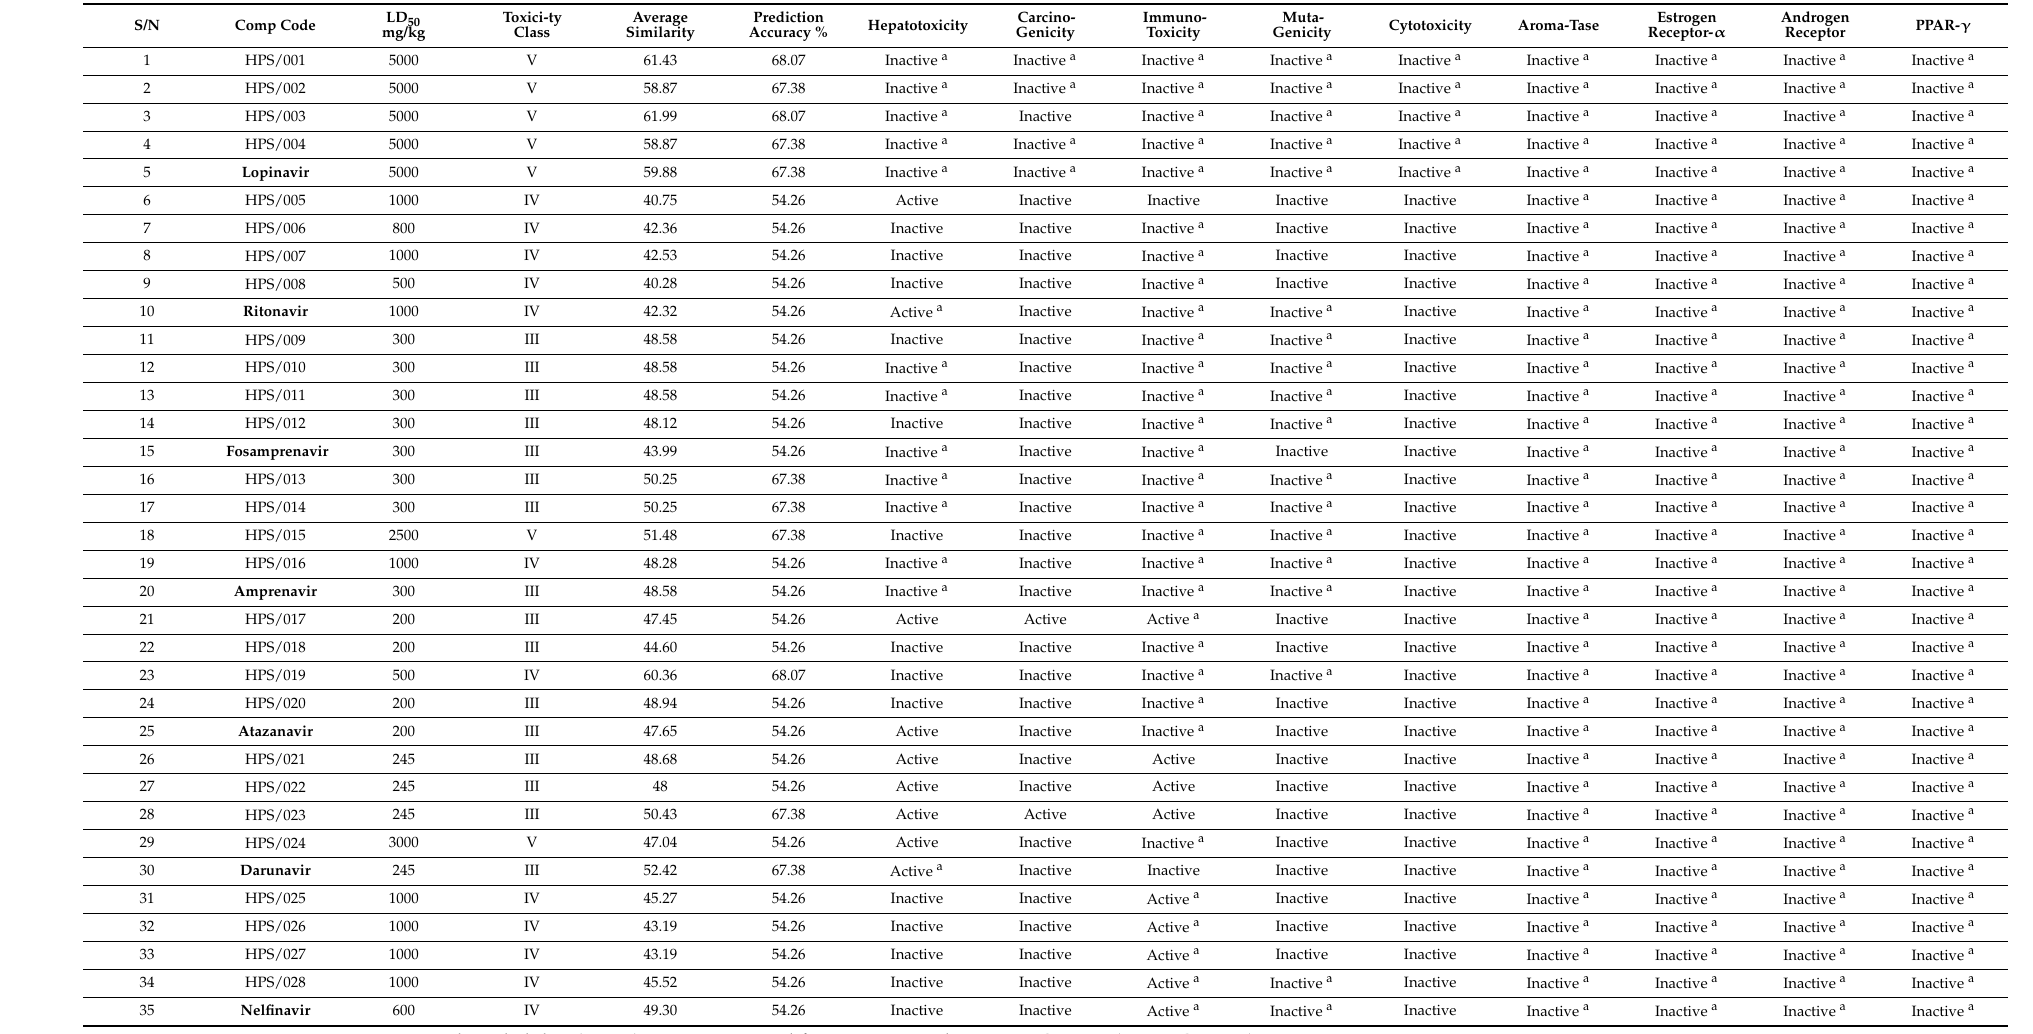
Table 6. The results of the toxicity test with